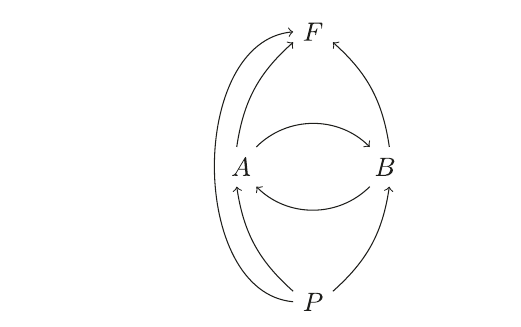
Fig. 3 A unitary process with nodes A and B , root node P (in the global past) and leaf node F (in the global future). Here with P out = QS and F in ¼ Q 0 S 0 ; the quantum SWITCH is an example of such a process.